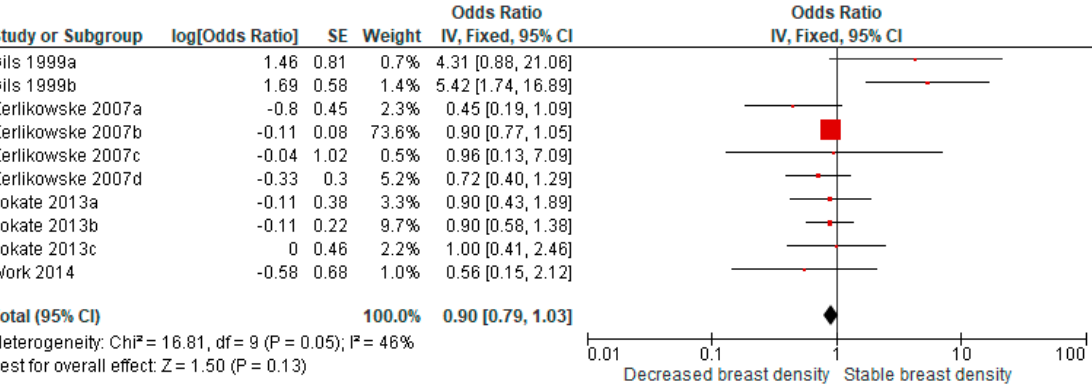
Figure 5. Pooled analysis for breast cancer risk in relation to decreased breast density over time (studies presenting odds ratios). Gils 1999a: >25% to <5%; Gils 1999b: >25% to 5–25%; Kerlikowske 2007a: C to A; Kerlikowske 2007b: C to B; Lokate 2013c: >50% to